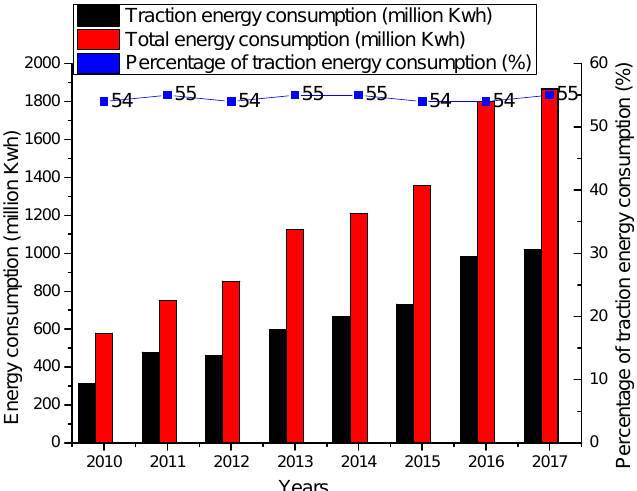
Figure 1. Energy consumption during 2010–2017 in Beijing urban rail